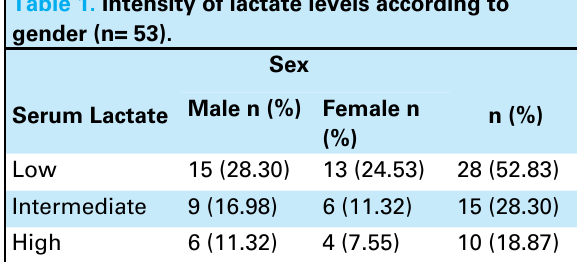
Table 1. Intensity of lactate levels according to gender (n= 53).